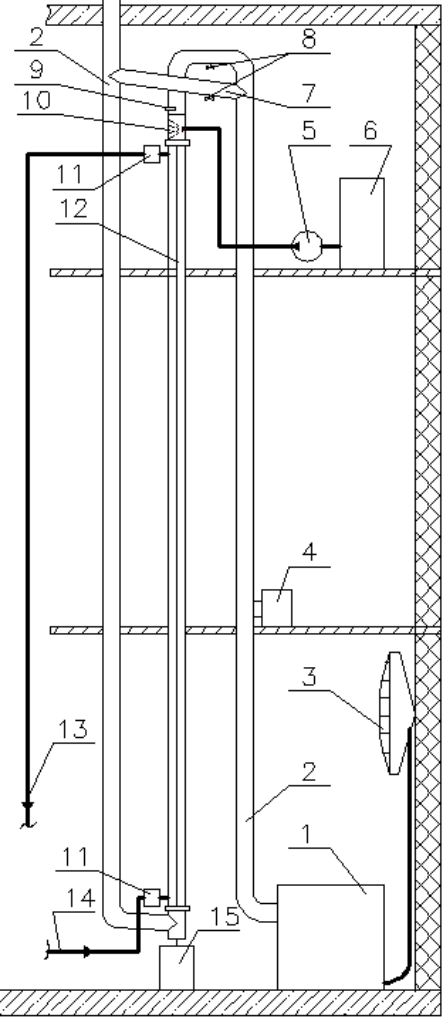
Figure 1. (1) boiler; (2) flue gas pipe; (3) heat exchanger (fan-coil type); (4) flue gas exhauster; (5) water injection supply pump; (6) injection water tank; (7) bypass pipe; (8) damper; (9) inlet flue gas